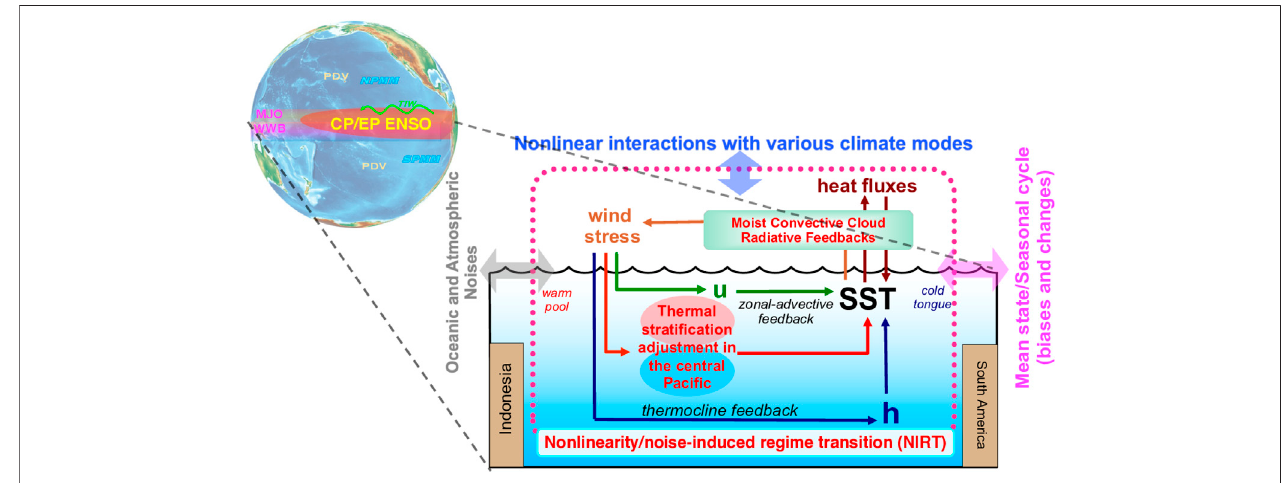
FIGURE 2 | Schematic diagram (modi fi ed based on Whittenberg 2018) of major modes of variability in the Paci fi c and key ENSO atmospheric and oceanic processes.